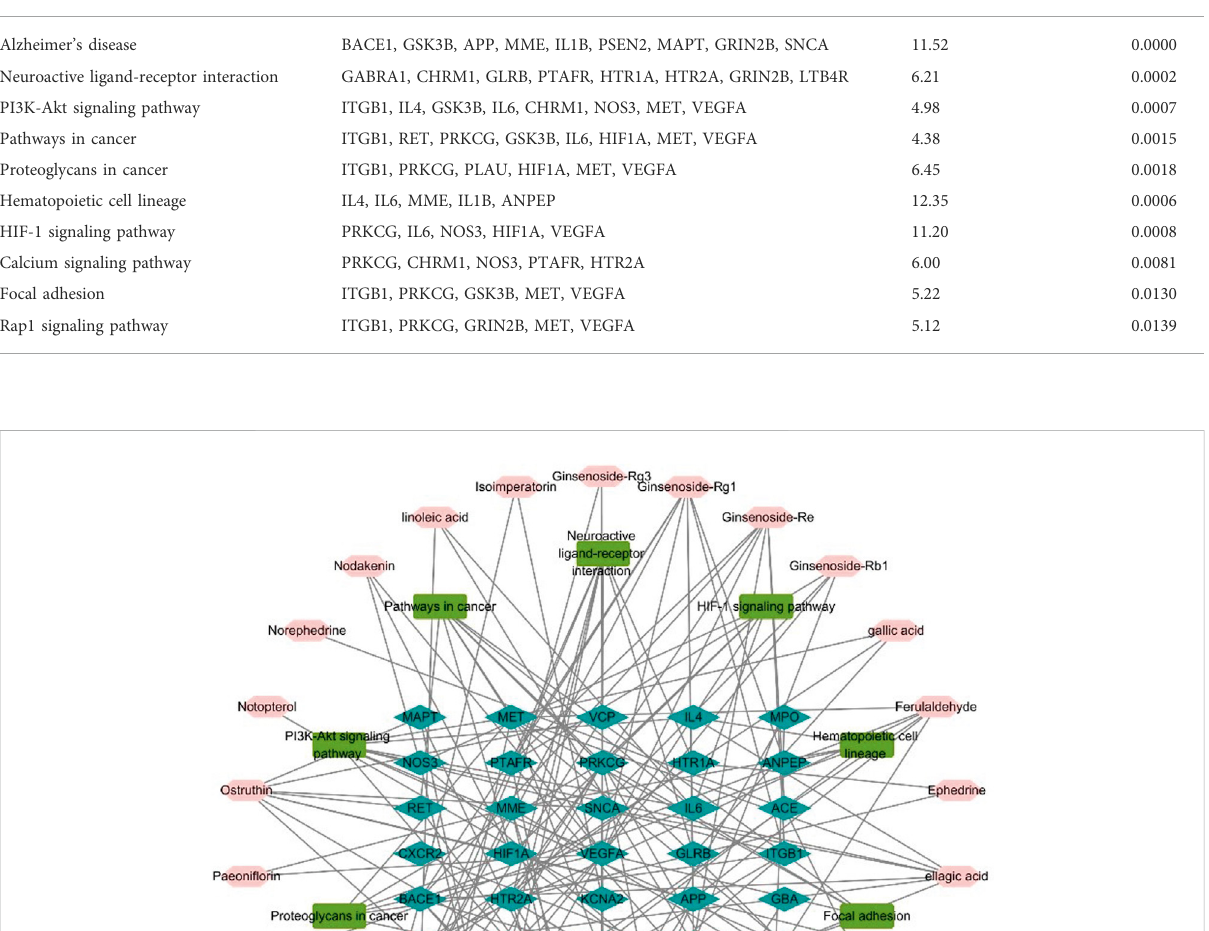
TABLE 4 The enriched KEGG pathway and the related genes. Pathway